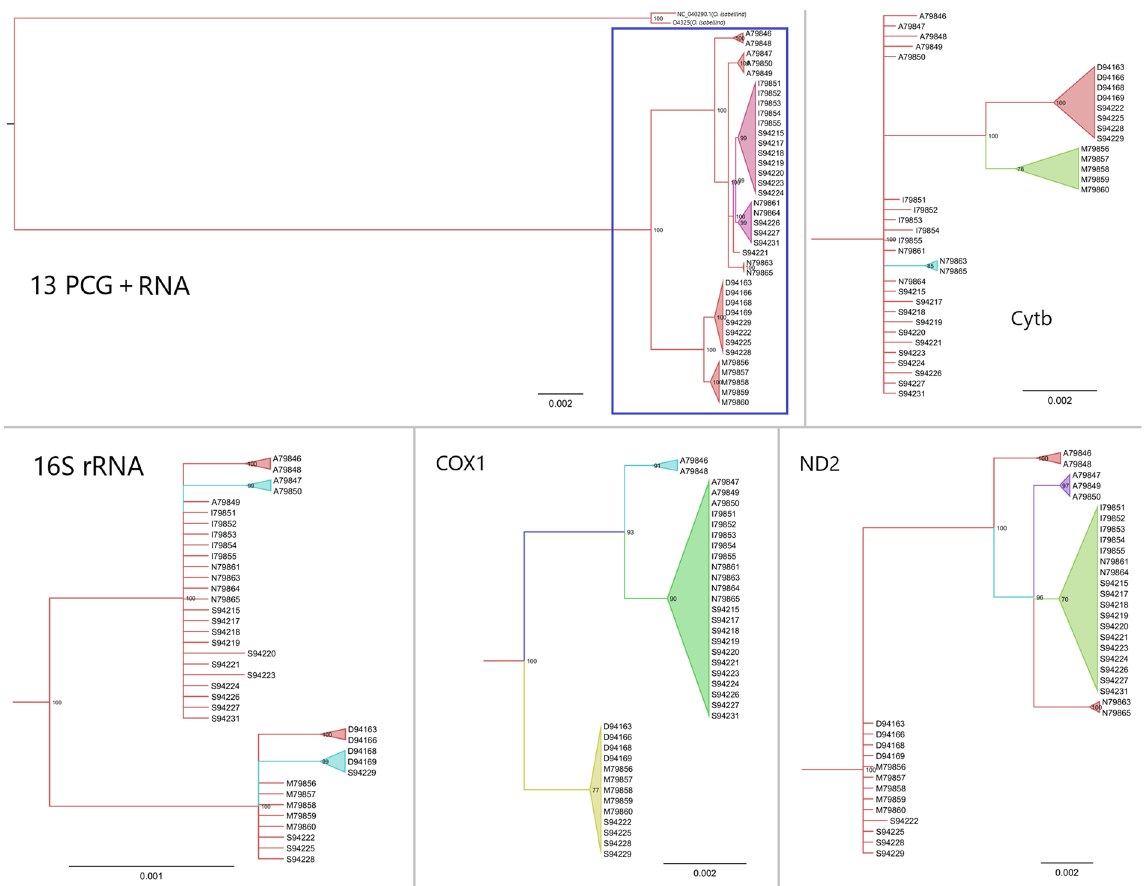
Figure 3. MrBayes reconstruction of the Oenanthe oenanthe and it’s outgroup Oenanthe isabellina . Numbers above nodes refer to the support values of Bayesian posterior probability. Sample name indicate the localities by the capital letter, ‘A’ refers to Alaska; ‘D’ refers to Germany; ‘I’ refers to Iceland; ‘M’ refers to Morocco; ‘N’ refers to Norway and ‘S’ refers to Sweden. Samples from Morocco are black Seebohmi Wheatears ( Oenanthe seebohmi ); samples from Iceland are Greenland Wheatears ( O. o. leucorhoa ); samples from Alaska, Germany, Norway and Sweden are nominate wheatears ( O. o. oenanthe